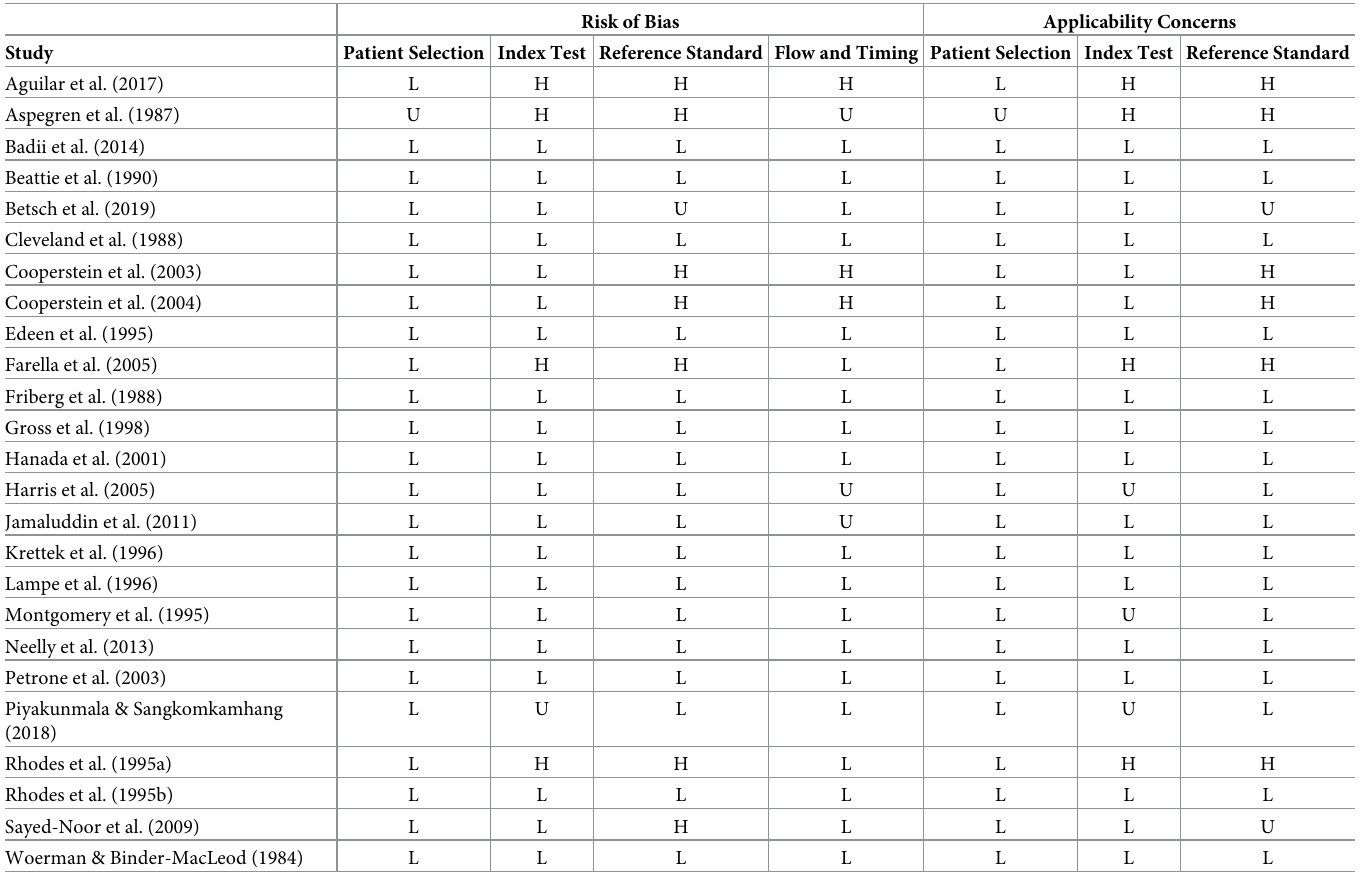
Table 1. QUADAS 2- tool for the evaluation of quality of the included validity studies on clinical assessments for the measurement of leg length discrepancy (n = 25).